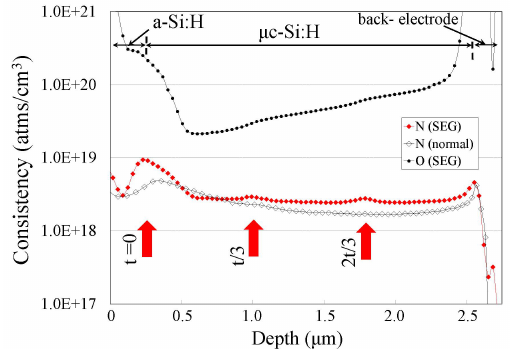
Figure 5. Profile of impurities about nitrogen and oxygen in cell A which used the SEG by SIMS. The nitrogen profile for normal-condition cells is also shown. Results were expressed in the direction reverse to the deposition direction.